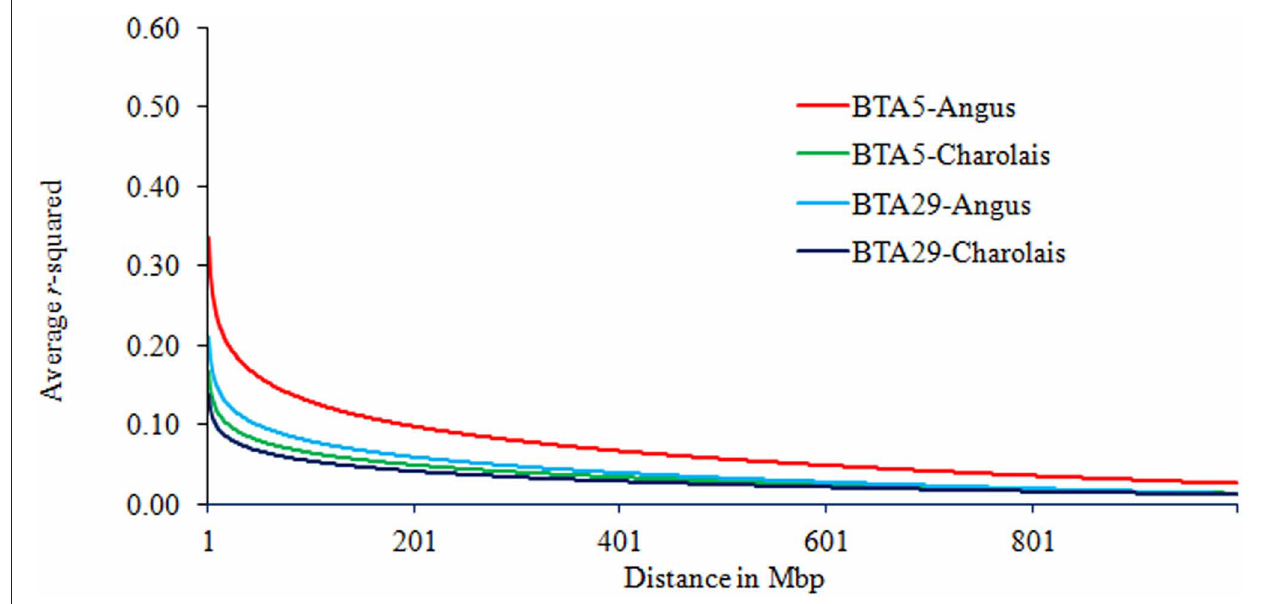
FIGURE 3 | Trend lines of average LD over genomic distance on chromosomes 5 and 29 in Angus and Charolais.